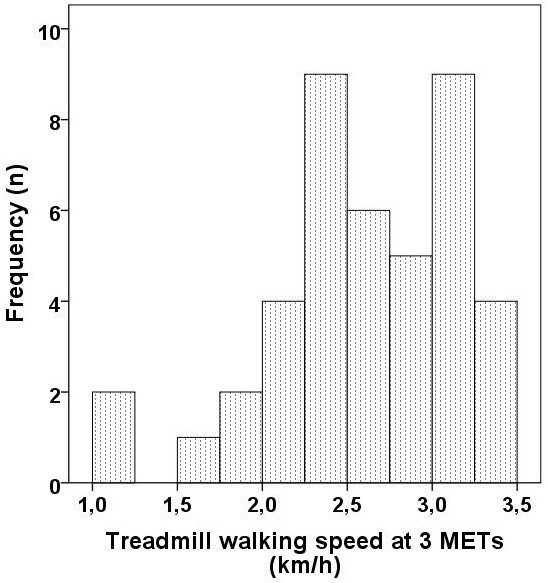
Histogram showing the distribution of treadmill walking speeds at three METs.